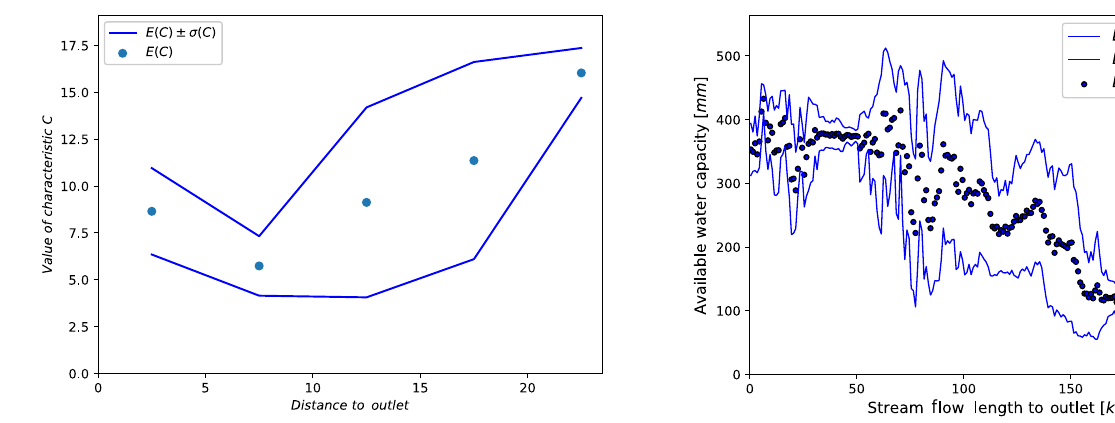
Figure 4. Distance-factor function of sample data in a synthetic catchment.